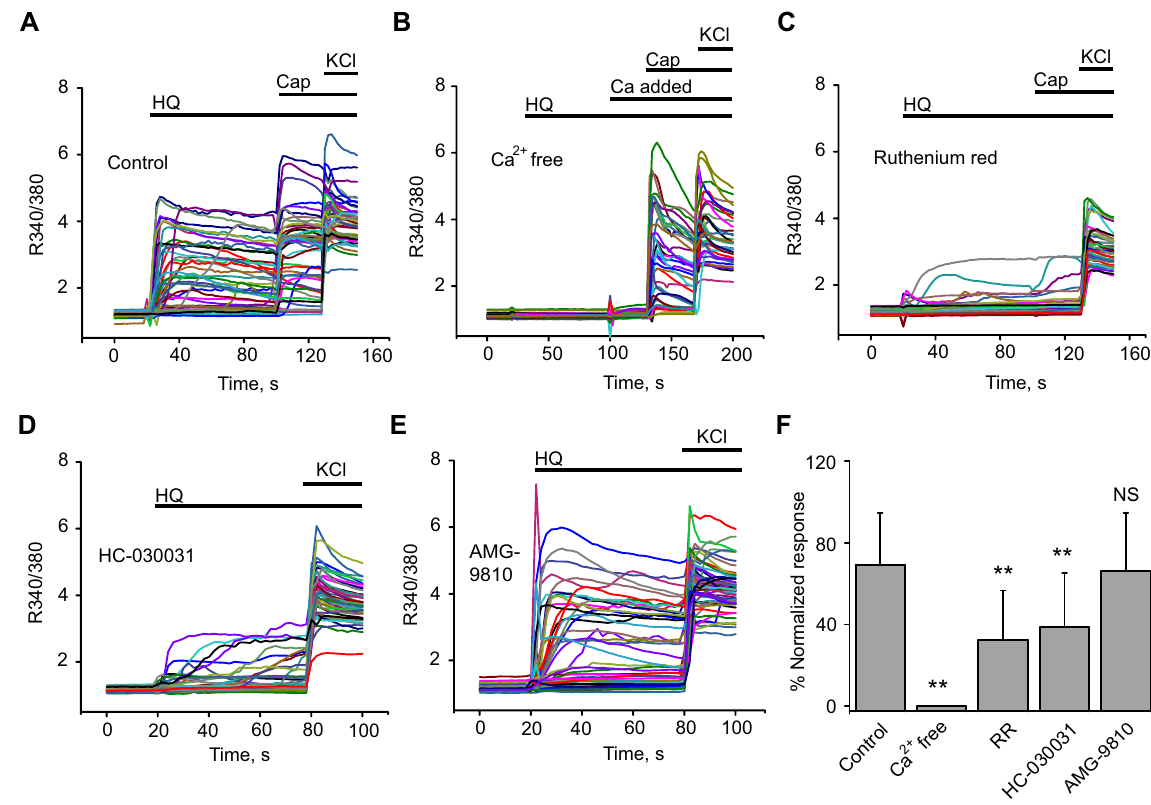
Figure 5. Pharmacological analysis of HQ-induced Ca 2 + responses in mouse sensory neurons. ( A – E ) Overlaid Ca 2 + imaging traces induced by HQ in control condition ( A ) and in the presence of Ca 2 + free extracellular solution ( B ), ruthenium red (10 µ M) ( C ), HC-030031 (100 µ M) ( D ) and AMG-9810 (6 µ M) ( E ) in mouse DRG neurons. Neurons were treated with HQ (30 µ M), and subsequently with capsaicin (200 nM) and KCl (40 mM) as shown. 2 mM Ca 2 + was re-added as shown in ( B ). ( F ) Summary of the pharmacological studies as shown in ( A–E ). All HQ-induced Ca 2 + responses were normalized to that of the KCl response and shown as % normalized response. n > 40 cells/group. ** p < 0.01 vs . control group. NS: no significance (p >